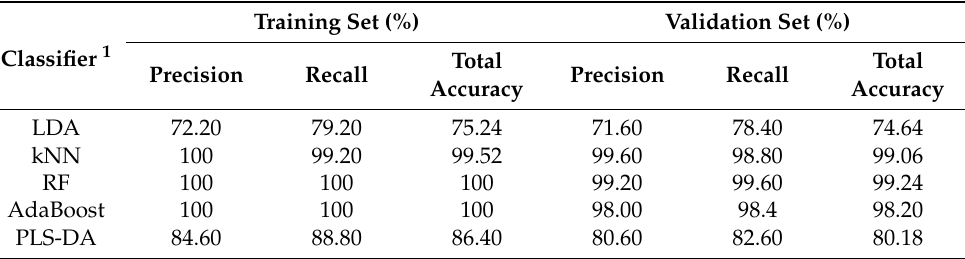
Table 2. Results of the PCA-based classification of control and infested samples for training and validation data sets based on manually selected